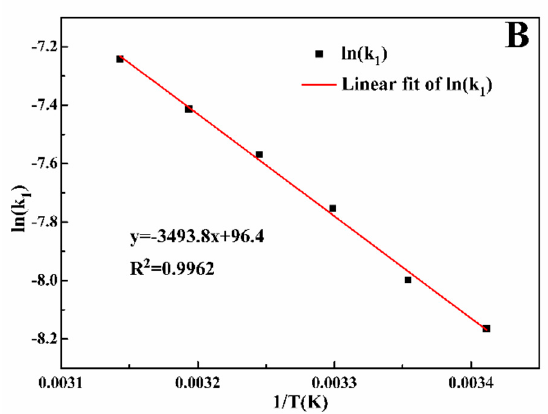
Figure 4. ( A ) ln([H 2 O 2 ]/[H 2 O 2 ] 0 ) ([H 2 O 2 ] 0 = 0.5 mM) as a function of reaction time at different reaction temperatures (293–318 K) with the catalyst dosage of 4.0 × 10 5 m − 1 ; ( B ) ln(k 1 ) as a function of (1/T) where k 1 were obtained from Figure 4A.